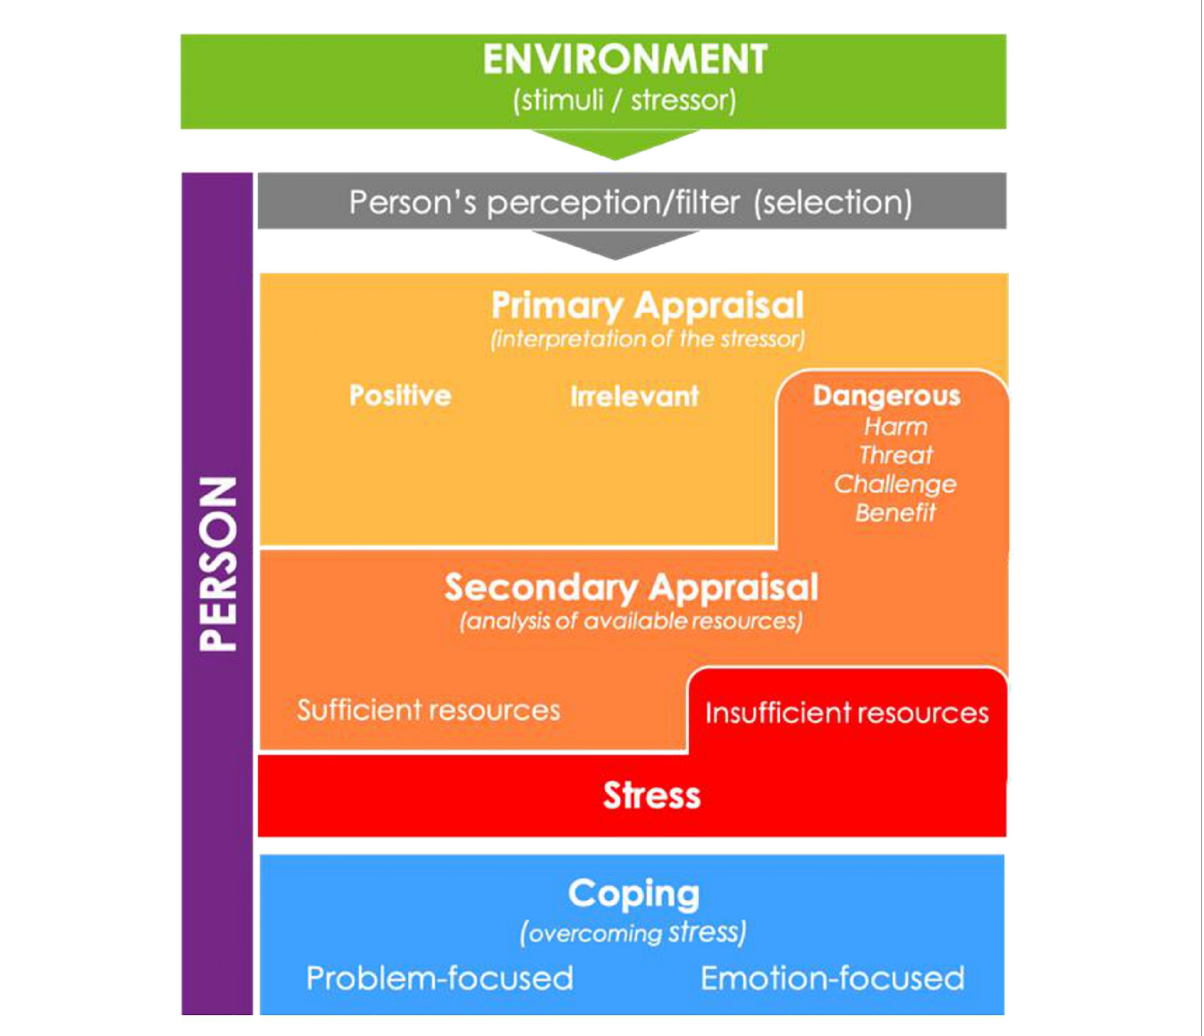
FIGURE2 Illustration of Lazarus Cognitive Mediational Model